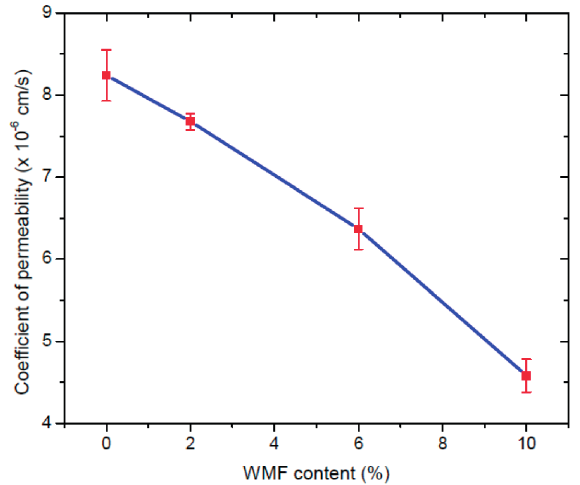
Fig. 9. Variation of permeability characteristics of the treated soil samples with their WMF